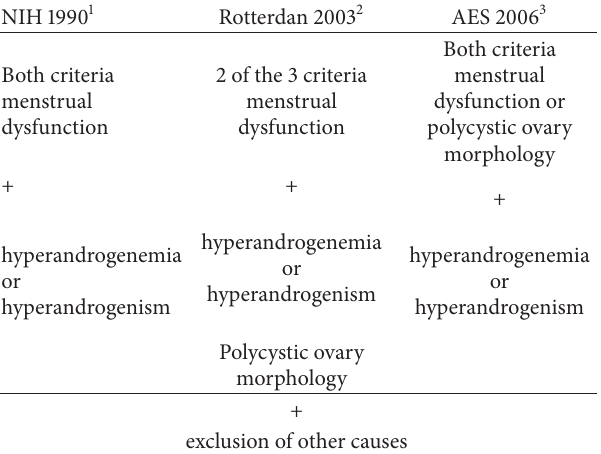
Table 1: Guidelines for the diagnosis of polycystic ovary